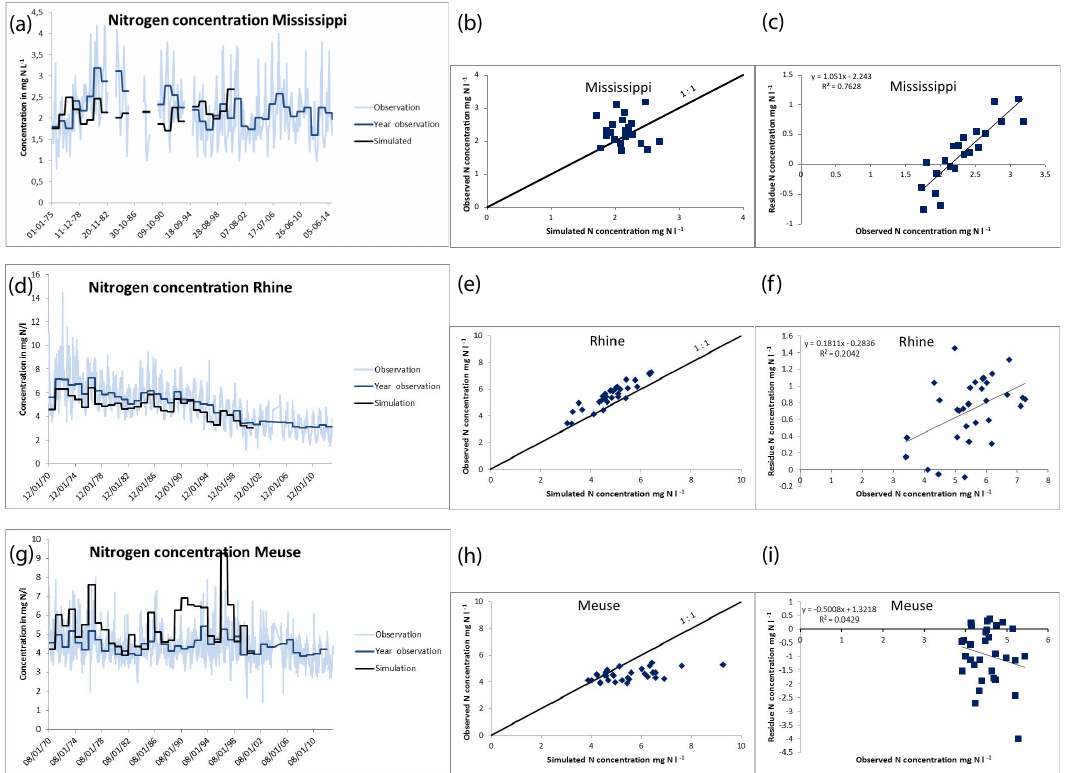
Figure 6. Comparison of modeled (black line) and measured (light blue, and aggregated yearly) discharge-weighed concentrations of total N in the rivers Mississippi (a–c) , Rhine (d–f) and Meuse (g–i) . Panels on the left are comparisons over time; panels in the center represent plots of simulations vs. observations with a 1:1 line, and panels on the right are the concentrations vs. the residues (observation minus simulation) with a regression